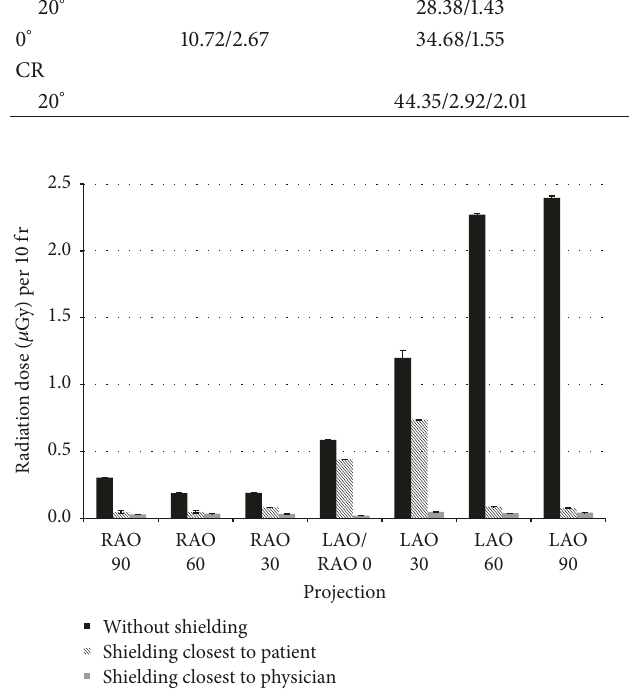
Figure 5: Doses from the scatter radiation in cardiology for RAO 90 ∘ to LAO 90 ∘ , CD/CR 0 ∘ .